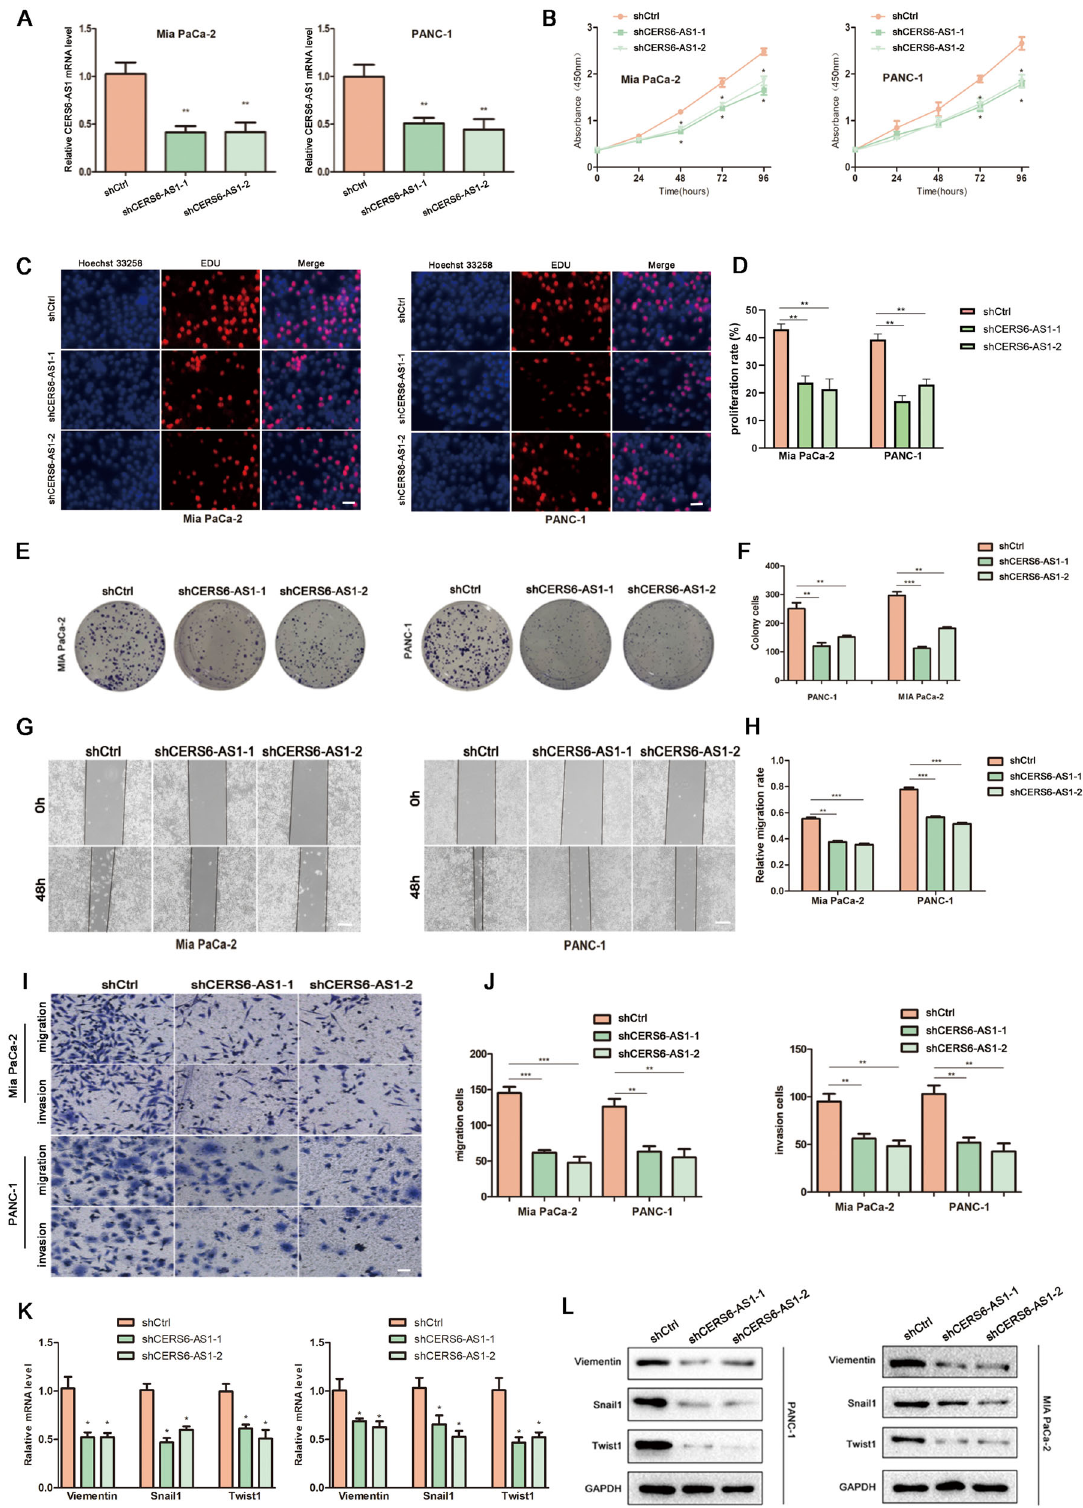
Fig. 2 CERS6-AS1 downregulation inhibits PC proliferation and invasion in vitro. A The effects of transfection of lentiviral transduction in PC cell lines (MIA PaCa-2, PANC-1) were detected by PCR analysis. B CCK-8 assay was performed to test the cell viability and proliferation in downregulated CERS6-AS1 groups (shCERS6-AS1) and negative control group (shCtrl). C , D EDU assays were performed to measure the proliferation ability of PANC-1 and MIA PaCa-2 (scale bar: 100 μ m). E , F Colony formation assay was performed to test the cell colony ability in downregulated CERS6-AS1 groups compared to shCtrl. G , H The migrated ability of MIA PaCa and PANC-1 was measured by wound healing assay (scale bar: 250 μ m). I , J Transwell assay was performed the migrated and invaded abilities in PC cell lines (scale bar: 100 μ m). The mRNA ( K ) and the protein ( L ) expressions of Vmentin, Twist1, and Snail1 were respectively detected in shCRES6-AS1 and shgroups by PCR analysis and western blotting. * p < 0.05, ** p < 0.01, *** p < 0.001. Cell Death and Disease (2021)